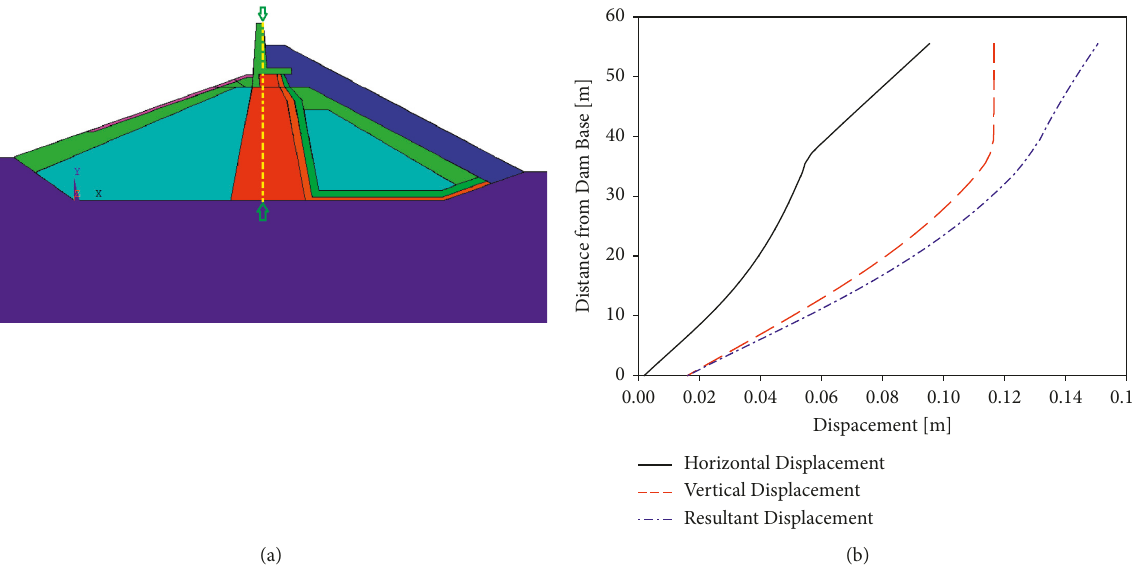
Figure 13: Displacement distribution along the dam body: (a) where stresses were taken and (b) horizontal, vertical, and resultant displacement.